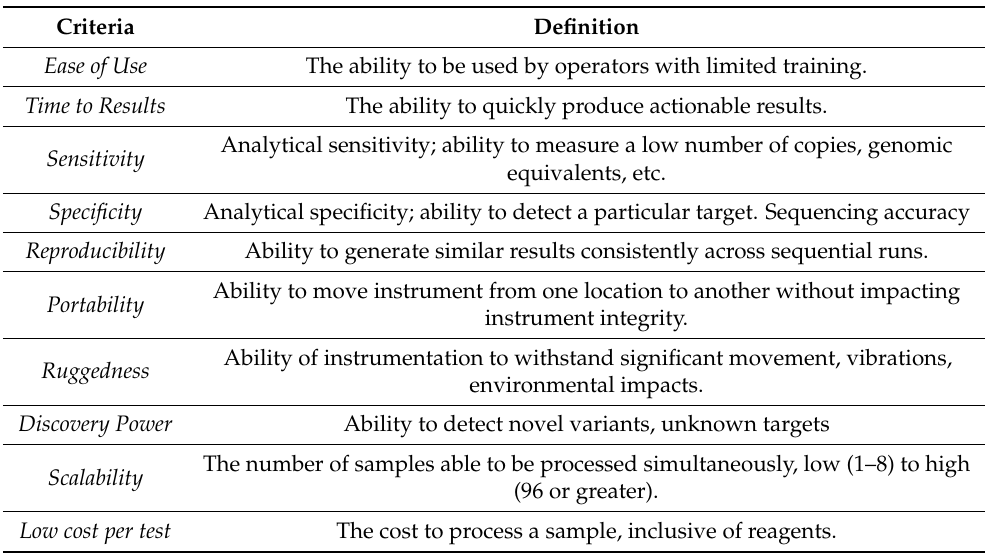
Table 2. Evaluation criteria and definitions. Ten criteria were used in our questionnaire.